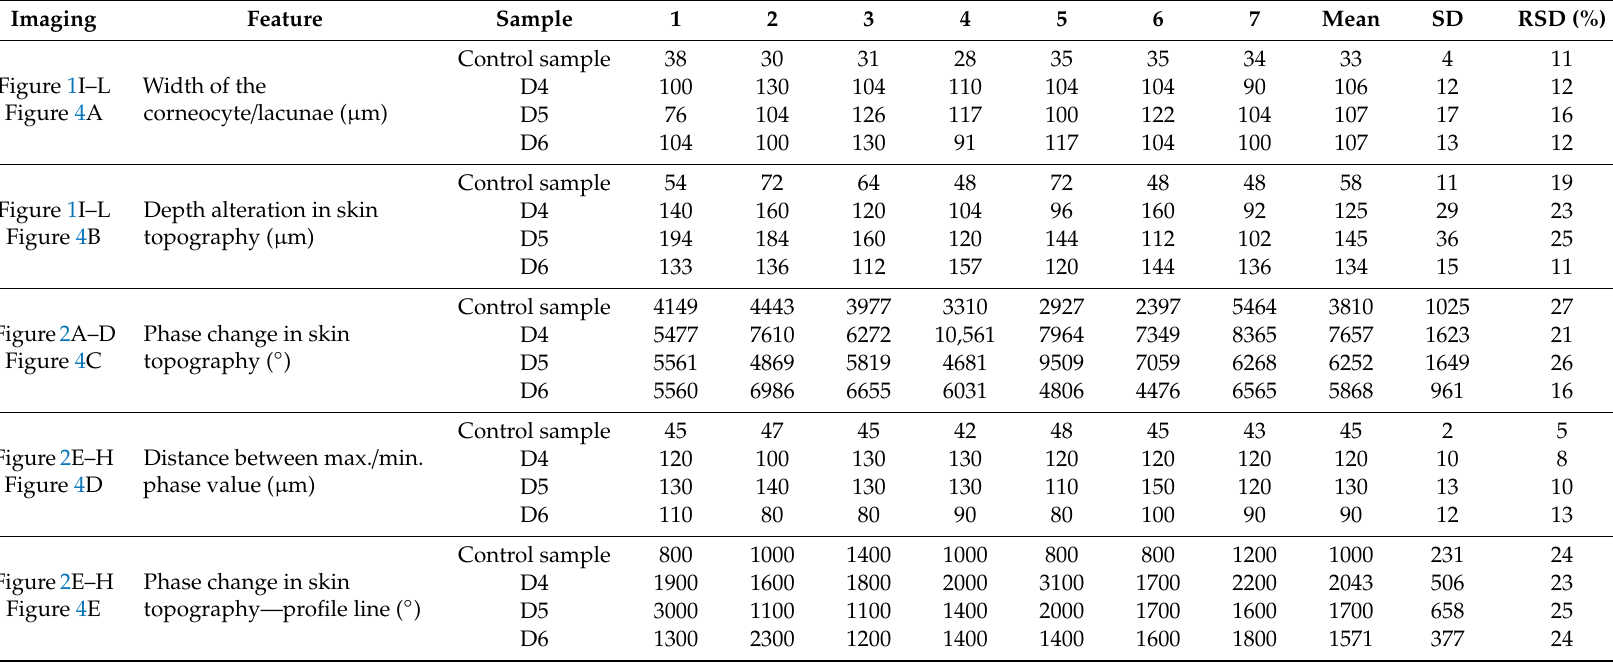
Phase change in skin topography—profile line ( ◦